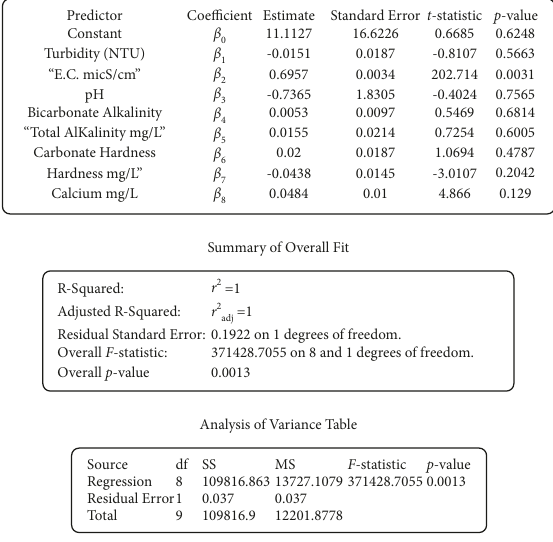
Figure 3: Regression analysis